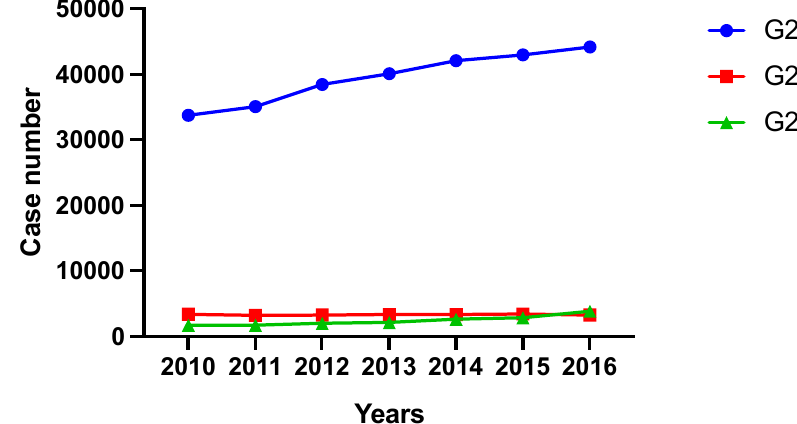
Figure 1. Case number development of inpatient treatment of PD and other basal ganglia disorders (ICD G20–G23) from 2010 to 2016 divided into ICD-categories. G20 = primary Parkinson’s syndrome; G21 = secondary Parkinson’s syndrome; G23 = other degenerative disease of the basal ganglia. Of all patients describe above, a proportion received inpatient PD-MCT. PD-MCT case numbers